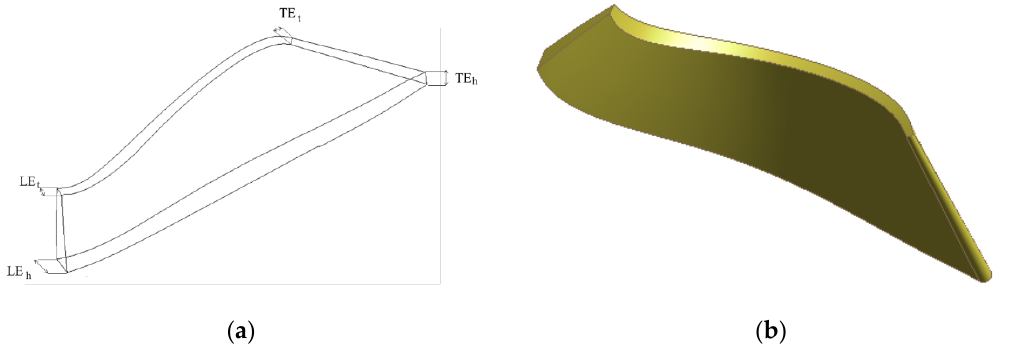
Figure 9. Definitions of blade thickness ( a ) and 3D model of turbine rotor blade ( b ).